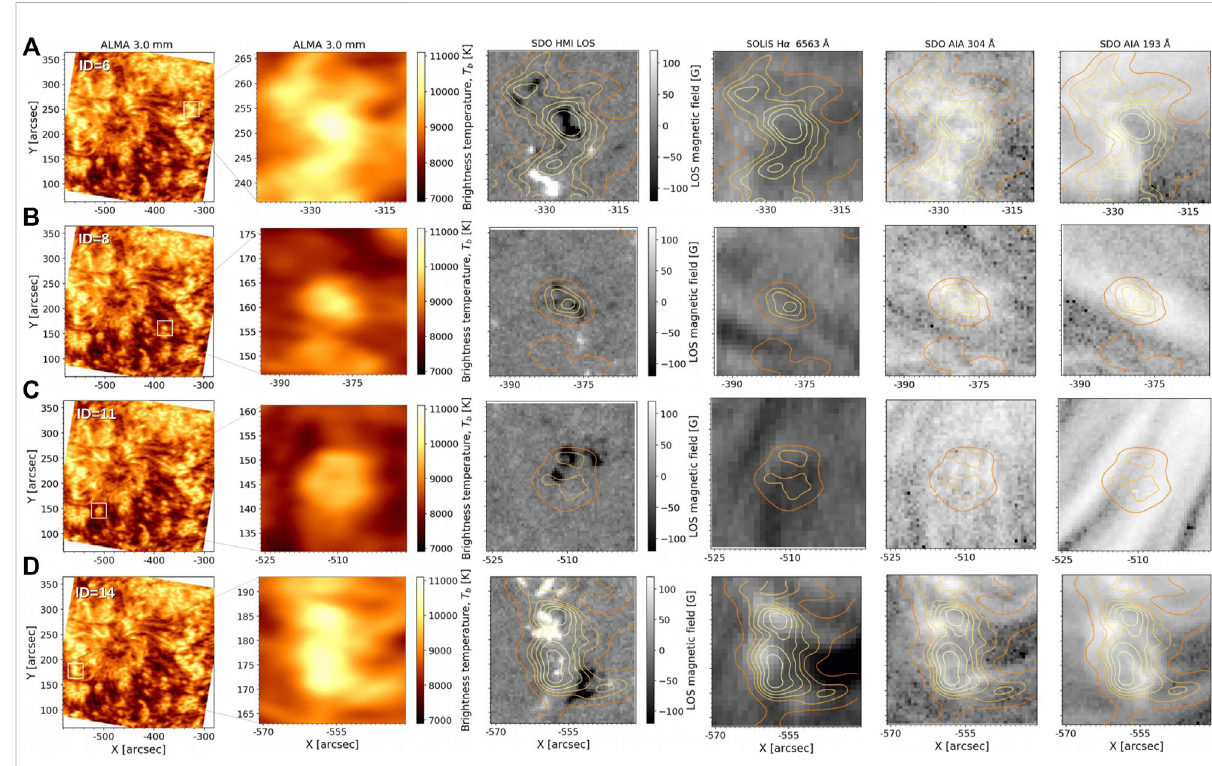
FIGURE 2 (A – D) four examplesofcomparisonbetween ALMA Band3brightnessstructures (secondcolumn)observed withintheFOVoftheAR12470on 16 December 2015 ( fi rst column) and HMI/SDO magnetogram (third column), SOLIS H α core 6563A (fourth column), AIA/SDO 304 and 193A ( fi fth and sixth columns, respectively). ALMA contours at 9000, 9500, 9750, 10000, 10250 and 10500 K are overlaid in each panel. White rectangles in the fi rst column mark the structures of interest. From Braj š a et al. (2021). Reproduced with permission ⓒ